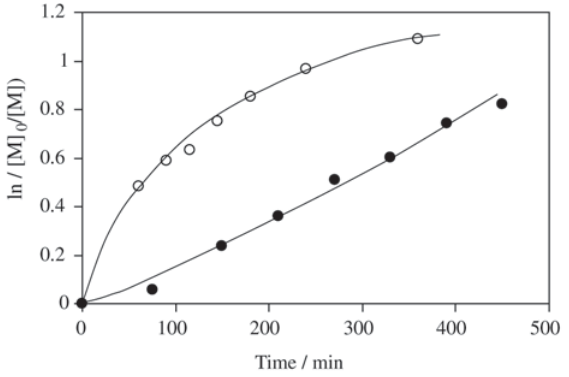
Figure 2. Semi-logarithmic kinetic plot for the synthesis of PMMA hybrids initiated by OCPS (filled) or OBPS (open) under similar reaction conditions. Lines are used only to guide the eye. [initia- tor] = 2.92 mM, [CuCl] = 23.4 mM, MMA:initiator group (–Cl or –Br) =